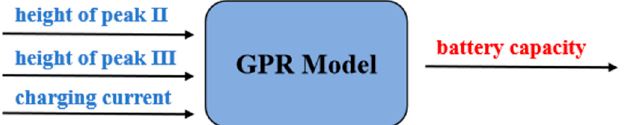
Figure 5. Capacity estimation mode based on GPR.